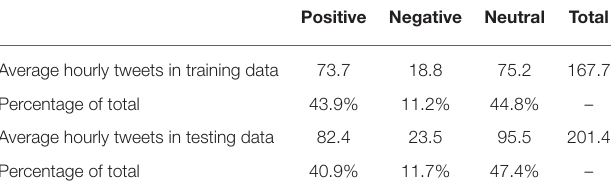
TABLE 4 | Discrepancies of Twitter sentiments between testing and training